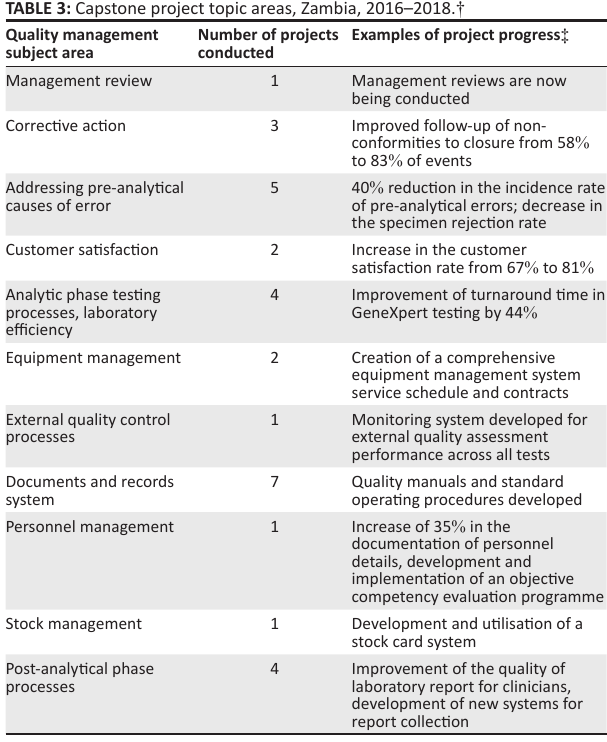
TABLE 2: Programme demographics, Zambia, 2016–2018.